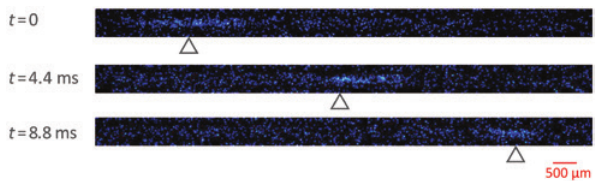
Figure 9: Optical diagnosis for continuous ignition of a plasma bubble in the main channel (internal trigger, gate width 500 μ s, gate delay 400 μ s, 10